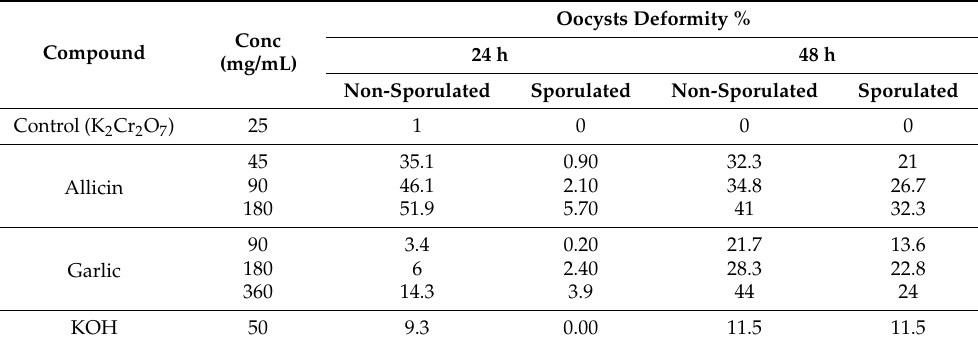
Table 2. Effect of different Allicin and alcoholic garlic extract concentrations compared to KOH 5% (as a chemical disinfectant) on the morphology of Eimeria tenella oocysts by light microscope and scanning electron microscope within 24 and 48 h post in vitro exposure.